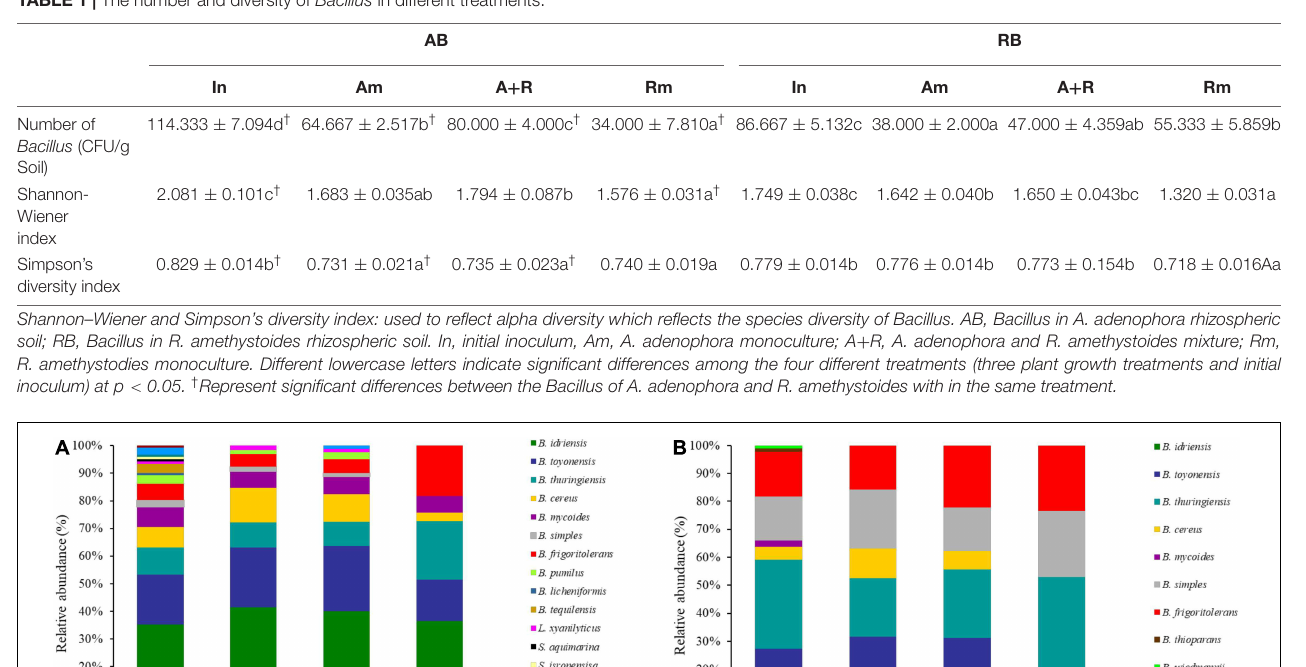
TABLE 1 | The number and diversity of Bacillus in different treatments.